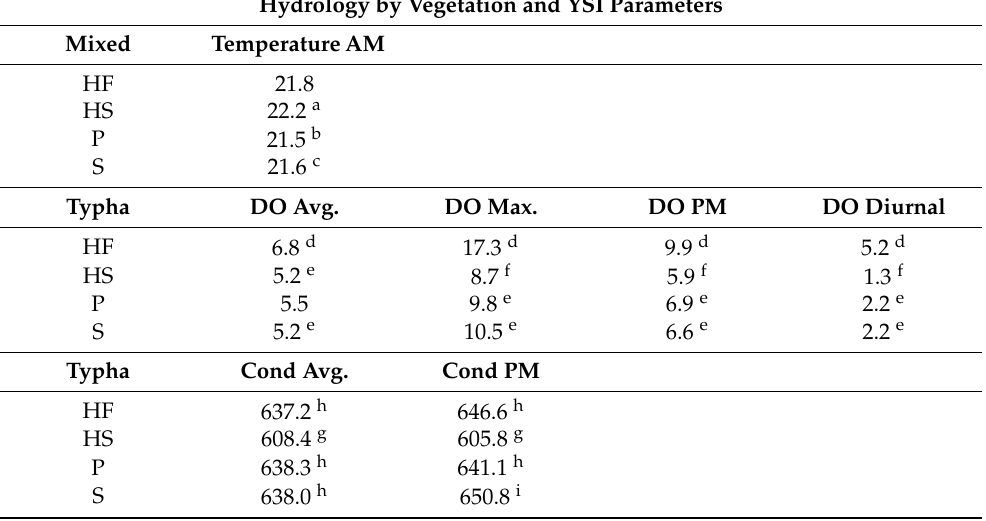
Table 4. Significant differences between YSI parameters by mesocosm hydrology type and vegetation